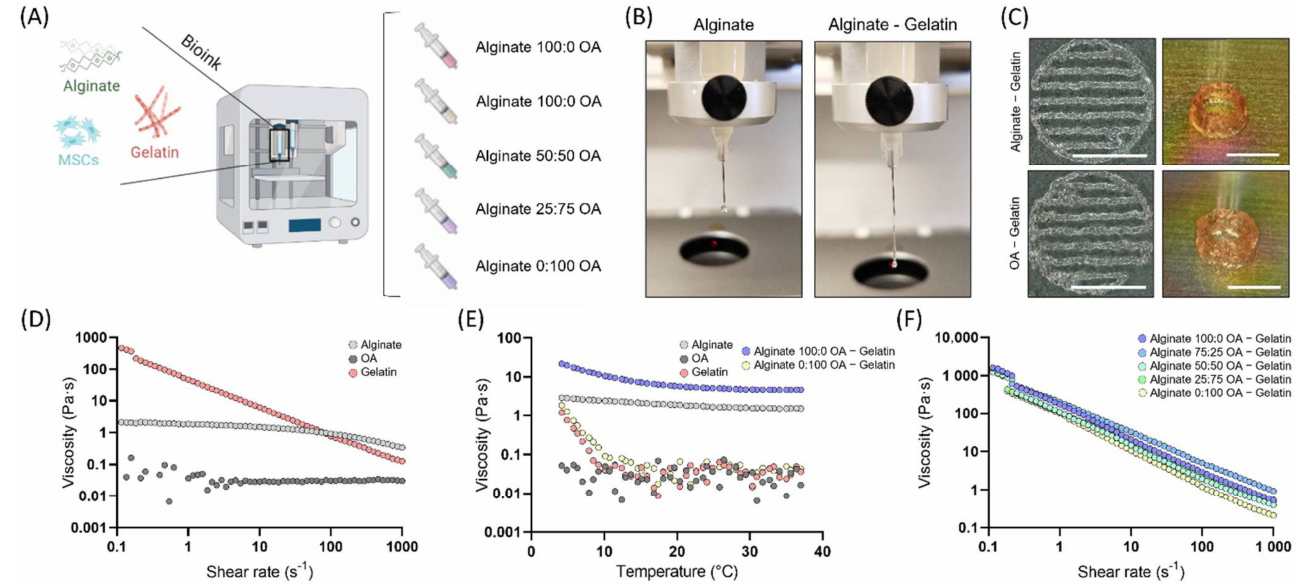
Figure 2. Bioink characterization. ( A ) Schematic of the experimental plan. Illustration of the bioink composition and different blends investigated. ( B ) Droplet/Filament formation demonstrating the role of gelatin for printing low viscous inks. ( C ) Printed hydrogels following grid and tubular patterns. Scale bar is equal to 6 mm. ( D ) Viscosity of the individual components (polymers) investigated under a shear rate in the range of 0.1 to 1000 s − 1 at 16 ◦ C. ( E ) Viscosity of bioinks and individual components as a function of temperatures changing from 37 to 4 ◦ C. ( F ) Viscosity of the different bioinks in the presence of shear rate in the range of 0.1 to 1000 s − 1 at 16 ◦